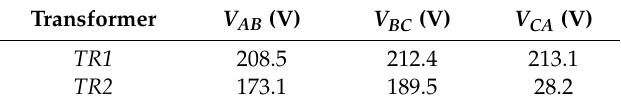
Table 2. Line voltages in the LV-side of transformers.